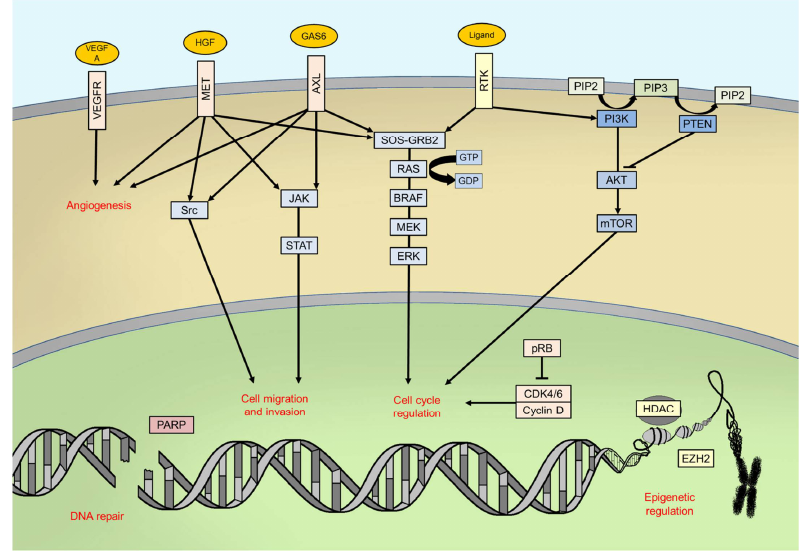
Figure 1. Main intracellular pathways and processes involved in melanomagenesis. RTK: receptor tyrosine kinase; PIP2: phosphatidylinositol 4,5-bisphosphate; PIP3: phosphatidylinositol (3,4,5)-trisphosphate. 3. BRAF Mutations in Melanoma: Epidemiology and Clinic-Pathological Correlations Since the early 2000s, BRAF has been identified as a commonly mutated gene in hu-